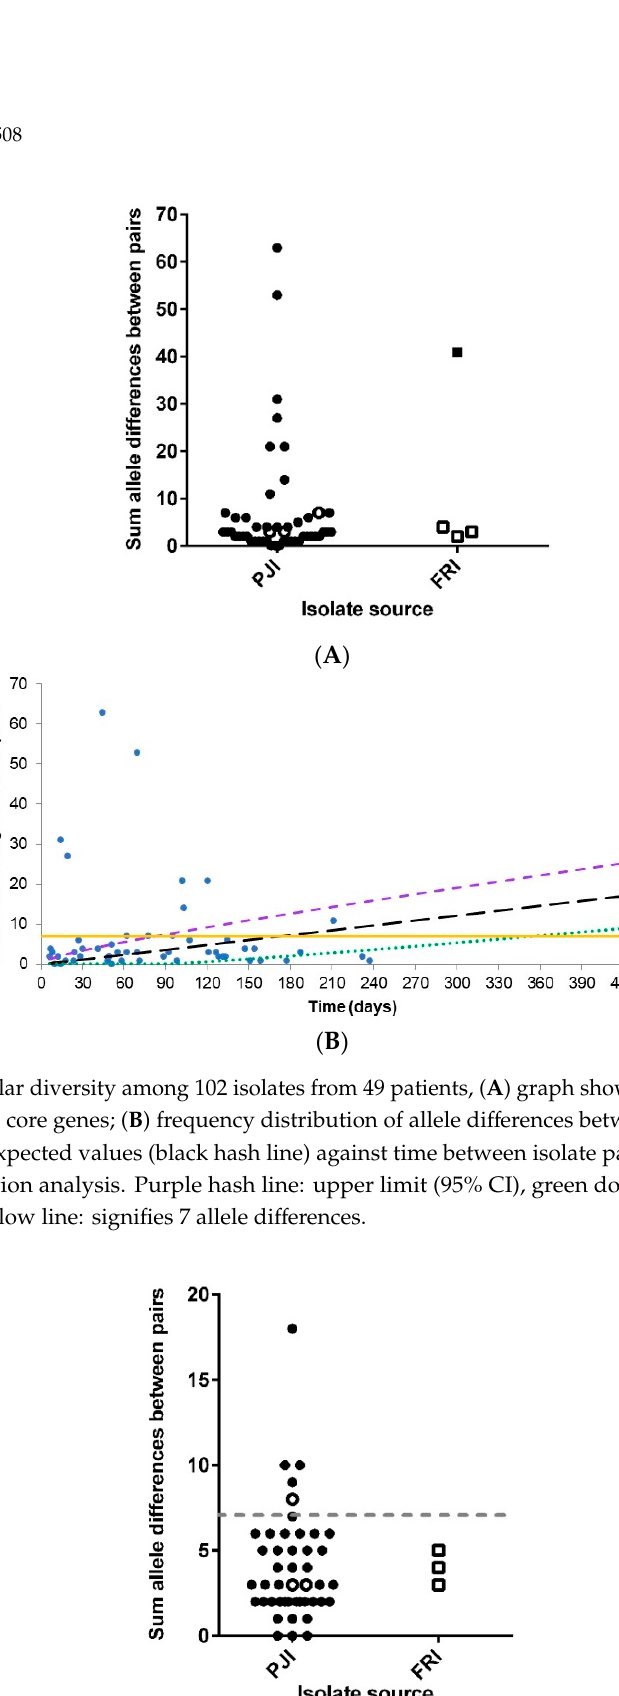
( B ) Figure 5. Molecular diversity within the accessory genome of the 77 isolates from 37 patients; ( A ) total number of accessory genes present (dashed line represents average number of genes); and ( B ) sum allele differences within the pairs in 2936 accessory genes. Open symbols represent patients with more than 3 isolates.